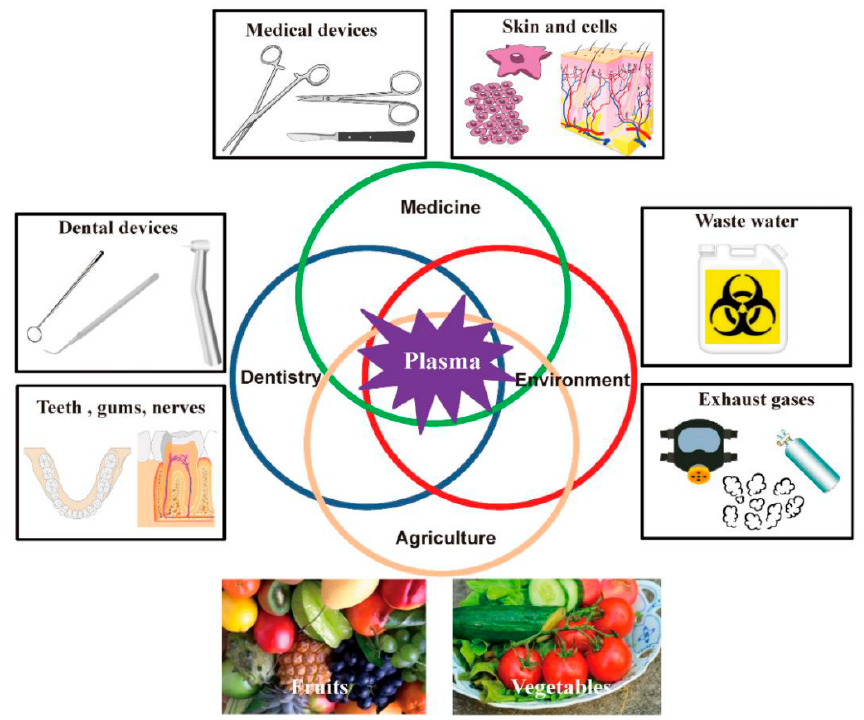
Figure 1. Recent progress in the application of non-thermal plasma for water purification, bio- sterilization, and decontamination (reprinted from [51]).